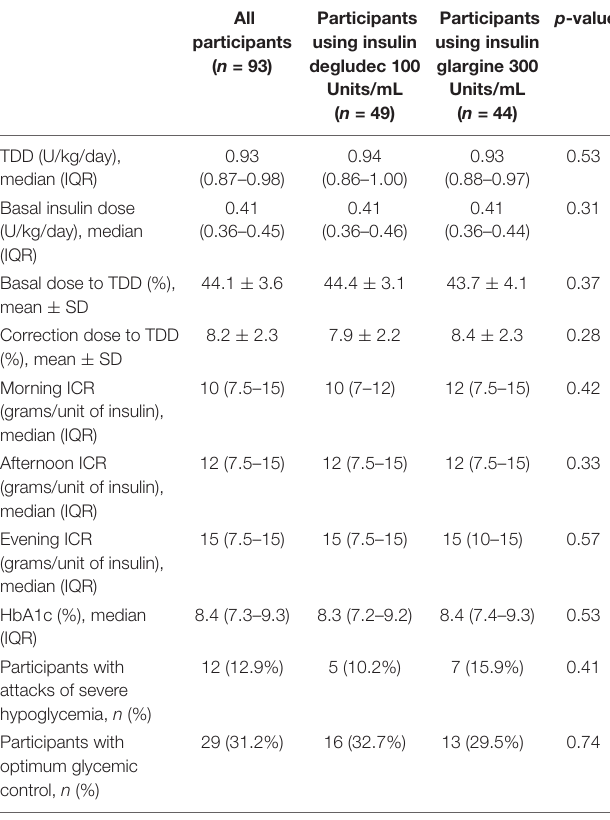
TABLE 2 | Insulin doses, insulin-to-carbohydrate ratio, and glycemic control parameters for the study